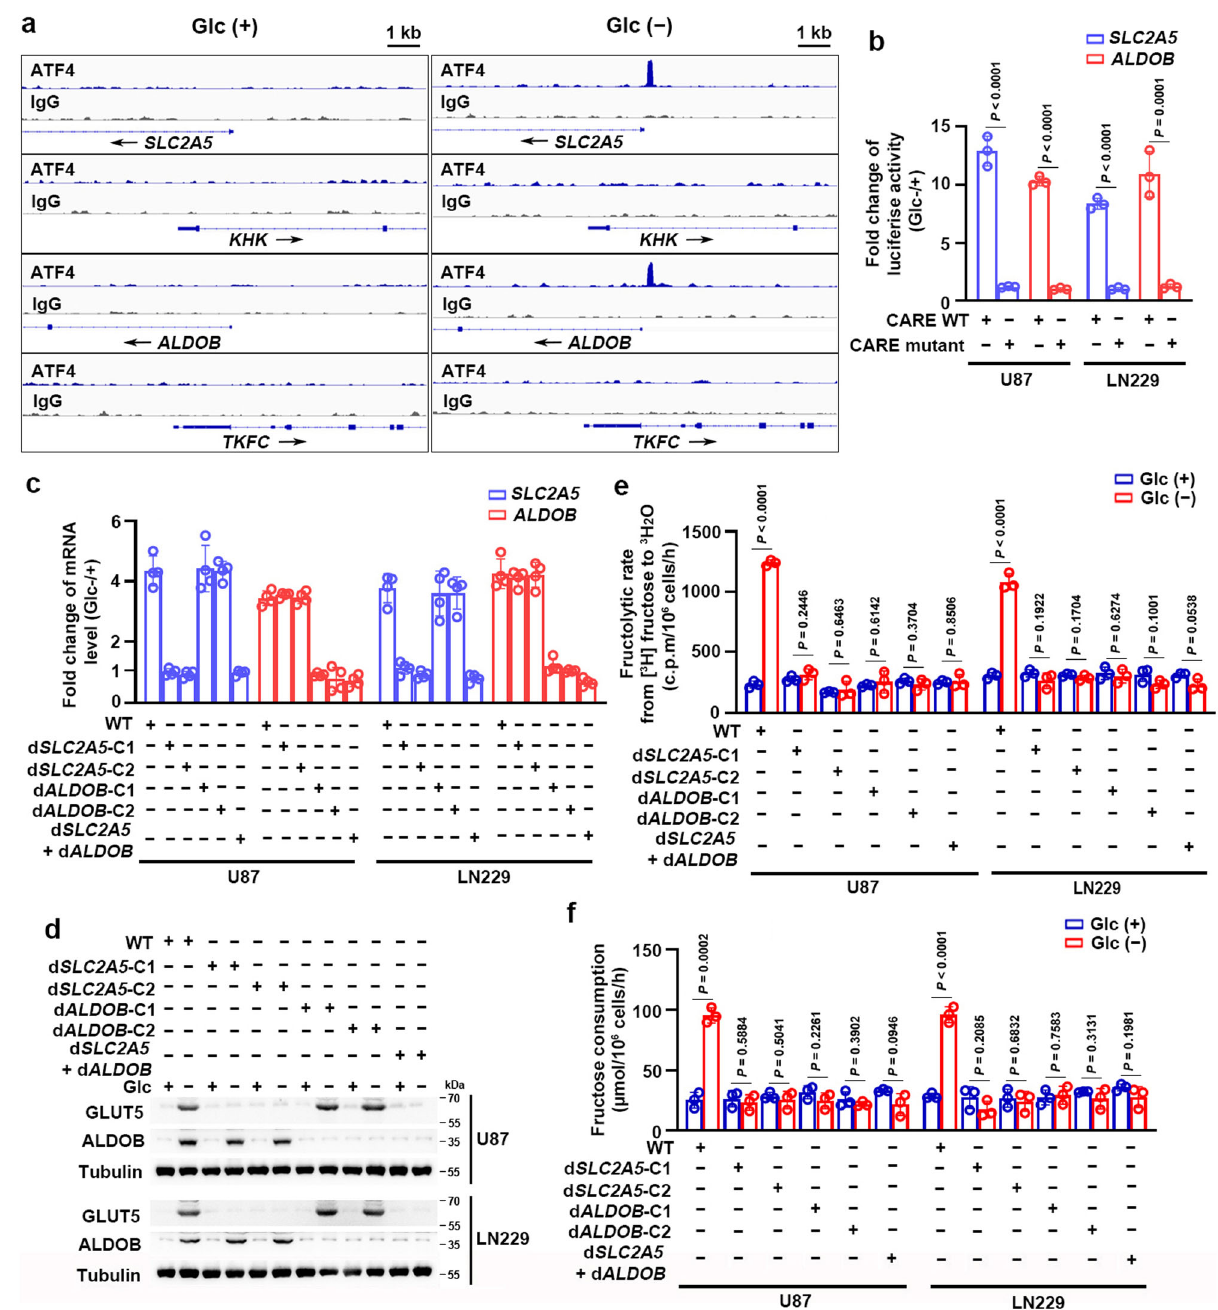
Fig.3 |ATF4 bindstothepromotersoffructolyticgenestoactivatefructolysis upon glucose deprivation. a U87 cells were treated without or with glucose deprivation for 18h. Chromatin immunoprecipitation (ChIP) combined with high- throughputsequencing(ChIP-seq)wasperformedusingtheATF4antibodyandthe promoters of indicated genes were visualized using Integrated Genome Browser. This experiment was performed twice independently with similar results. b U87 cells were infected with luciferase-reporter lentiviruses carrying SLC2A5 ( − 593 to +255bp) or ALDOB ( − 661 to +214bp) promoter without or with disruption of the CARE motif. These cells were treated without or with glucose deprivation for 18h. The fi re fl y luciferase activity was normalized with the cell numbers obtained from the duplicated samples and presented as fold change induced by glucose depri- vation. CARE, C/EBP-ATF response element. c – f U87 and LN229 cells without or with disruption of the CARE motifs located within the promoters of SLC2A5 or ALDOB were treatedwithout or with glucose deprivation for 18h. c , d Quantitative